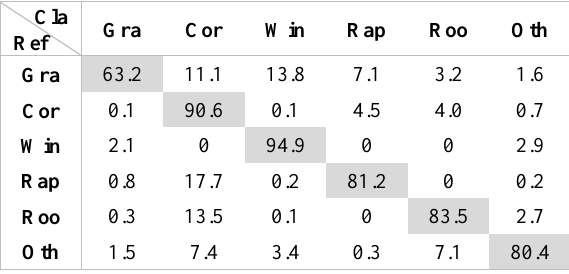
Table 2. Confusion matrix for CRF multi -classification